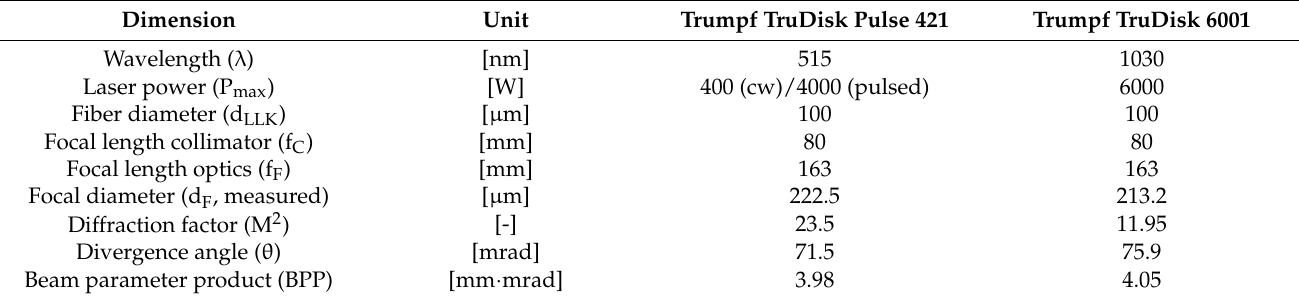
Table 2. Laser beam sources and optical setup used for the